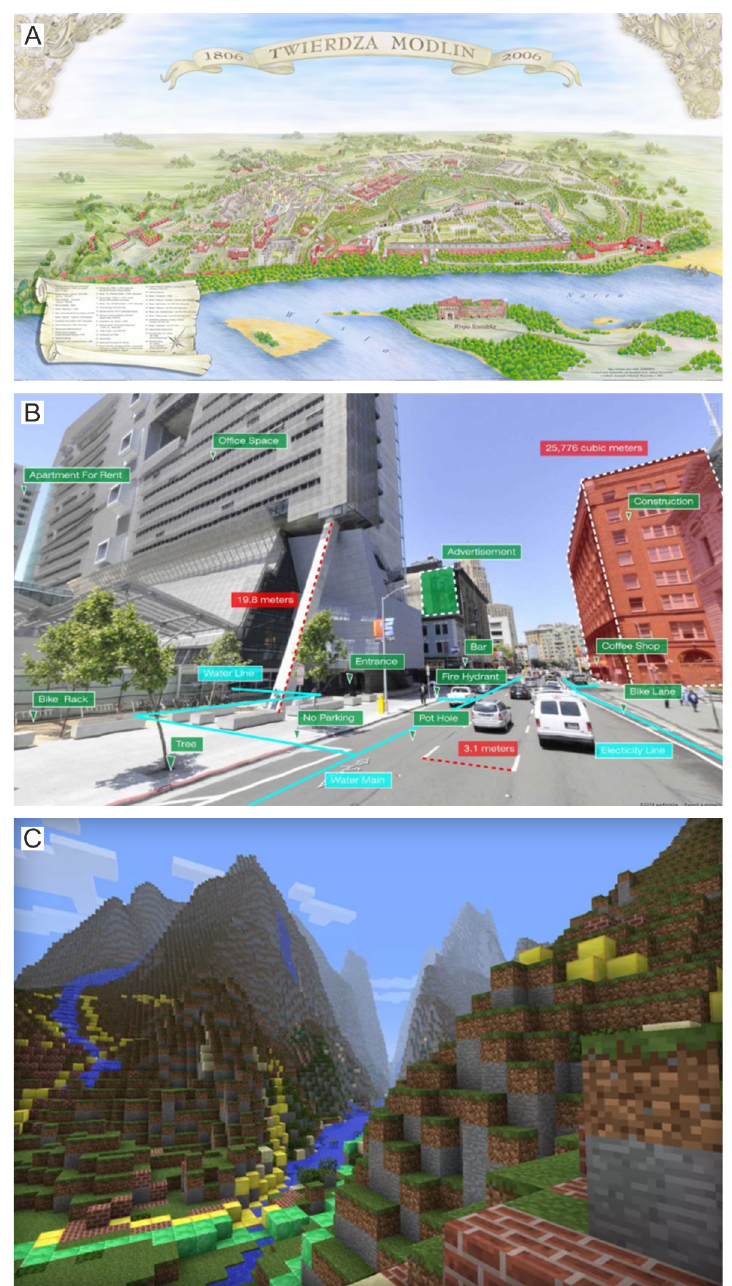
Fig. 2. Different ways of depicting space (selected examples analysed in the study): A – spatial model created manually in the form of a drawing (source: A. Lenkiewicz 2005, Faculty of Geodesy and Cartography Warsaw, University of Technology); B – visualization of the spatial model in the system of Virtual Reality (source: http://www. wired.com/); C – visualization of the spatial model in computer game Minecraft (source: